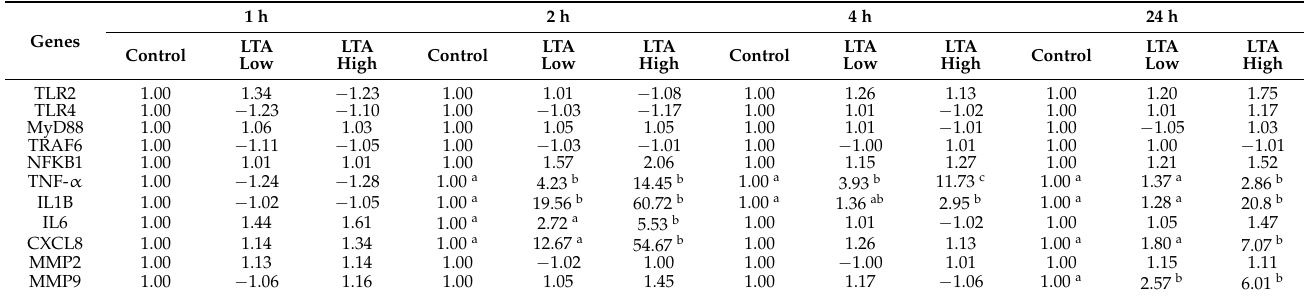
Table 2. Expression of measured genes of REC treated with medium only (Control), LTA low (1 µ g/mL), and LTA high (10 µ g/mL) for 1, 2, 4, and 24 h. n = 5 independent experiments. Values are the fold changes expressed relative to the untreated cells (Control). Control was set to